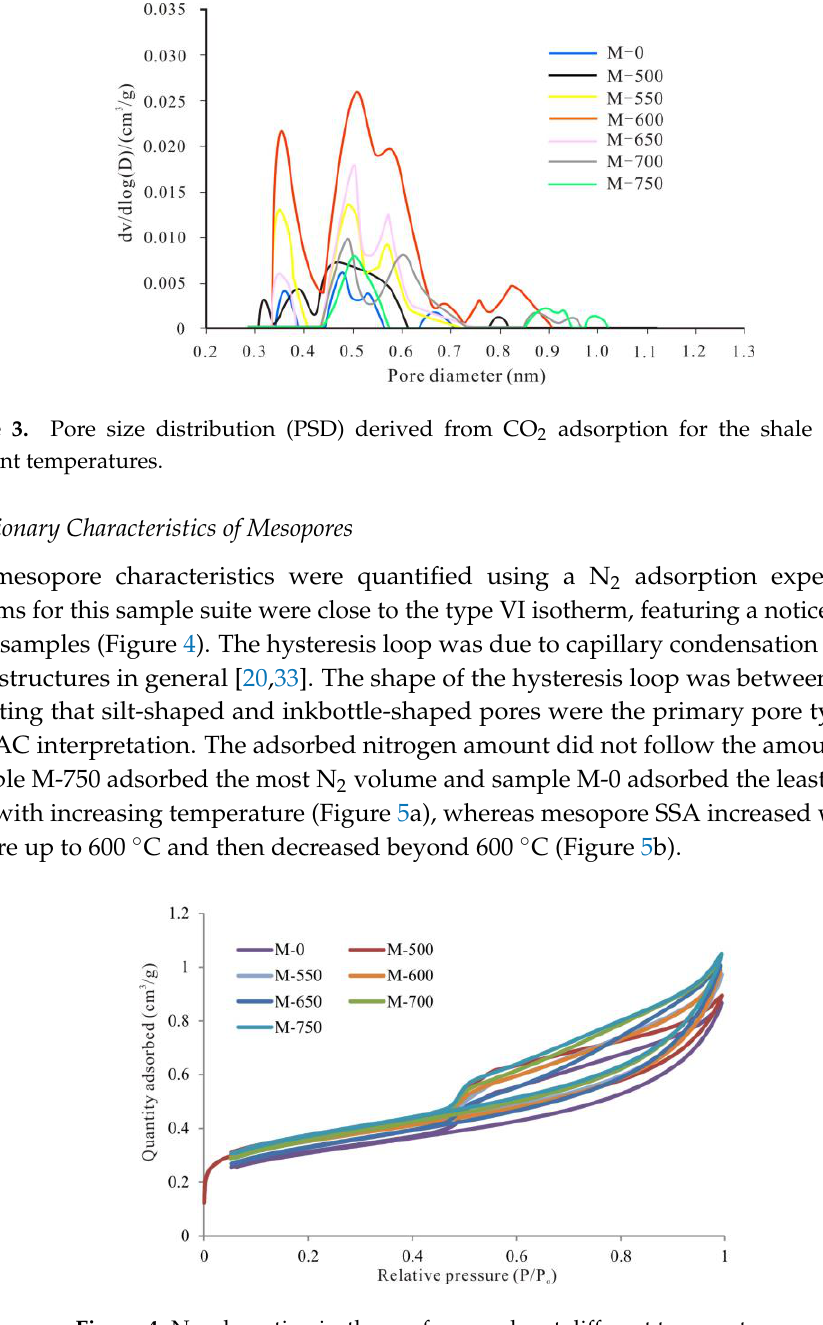
Figure 2. ( a ) Relationships between micropore pore volume (PV) and temperature (%Ro), ( b ) relationships between micropore specific surface area (SSA) and temperature (%Ro).